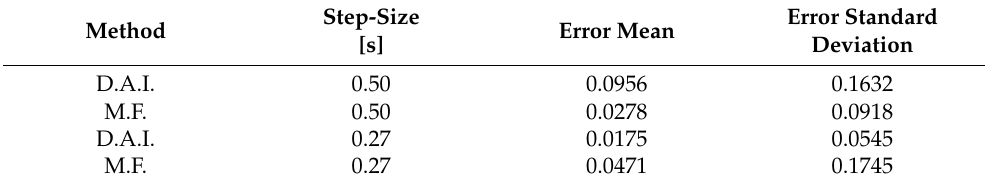
Table 1. Error distribution of D.A.I. and model-following method (M.F.) at varying step-sizes. Method